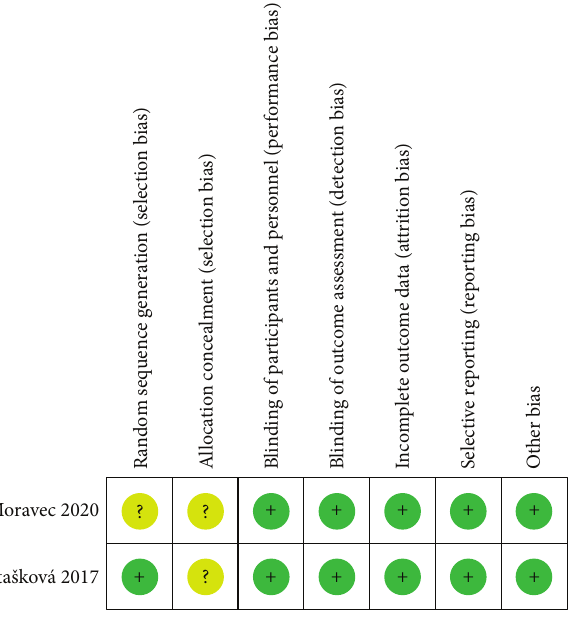
Figure 2: Risk of bias of included RCTs in the